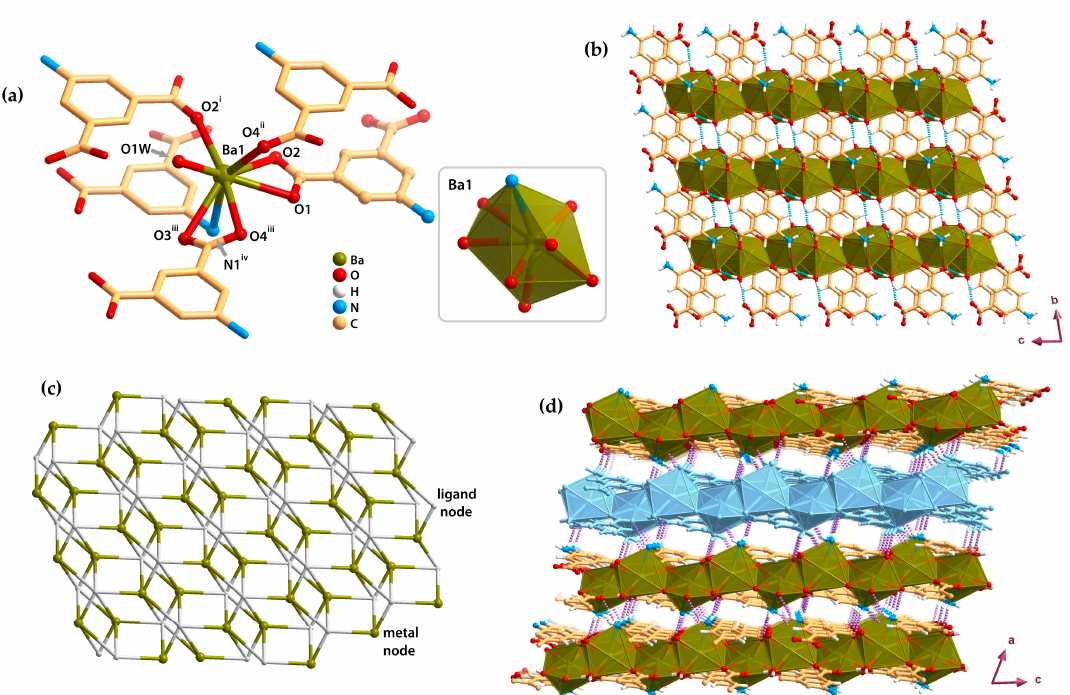
Figure 6. Selected details of the crystal structure of [Ba(aip)(H 2 O)] ( 6 ): ( a ) full coordination environment of Ba1 center and polyhedral representation of highly distorted dodecahedral geometry; ( b ) 2D metal–organic layer extended in the [1 0 0] direction of the unit cell; ( c ) the topology representation of the 2D metal–organic layer; ( d ) global packing arrangement viewed in the [0 1 0] direction of the unit cell, where one coordination layer is highlighted in the blue color.